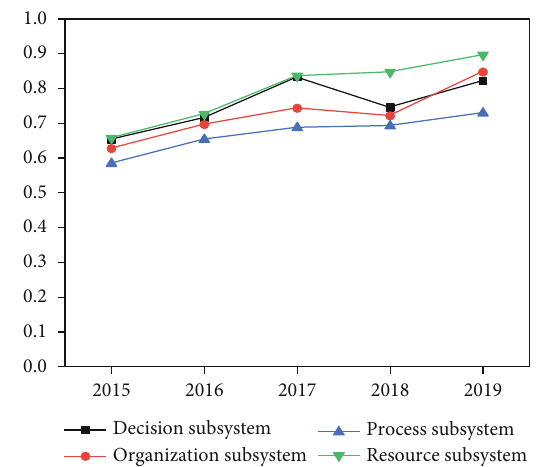
Figure 3: Synergistic degrees of CME management synergy subsystems in Henan Province (2015-2019).